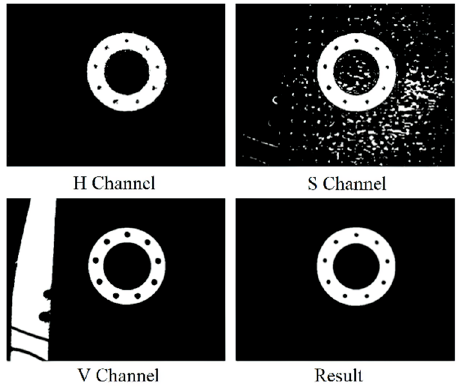
Figure 6. Results of target region extraction.